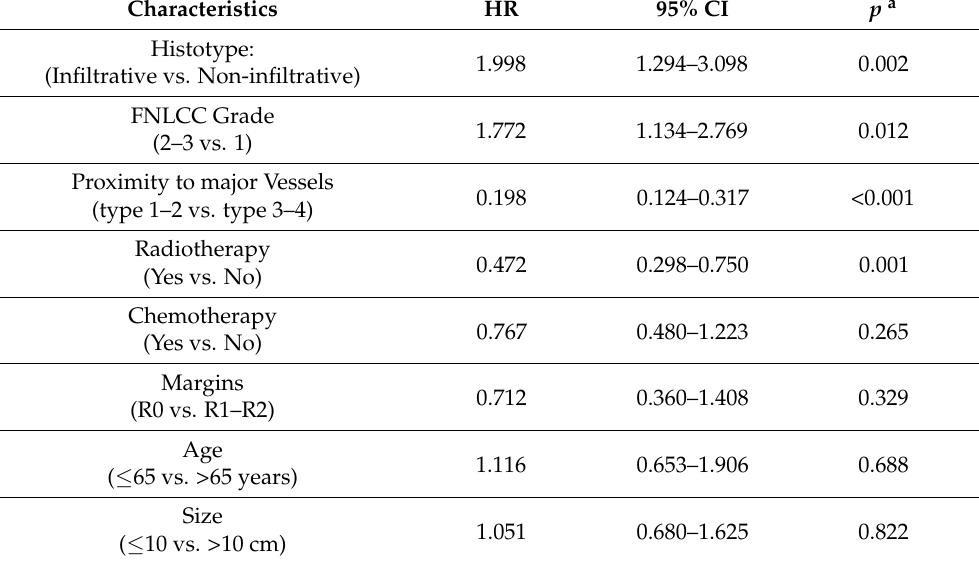
Table 2. Multivariate analysis for local recurrence.